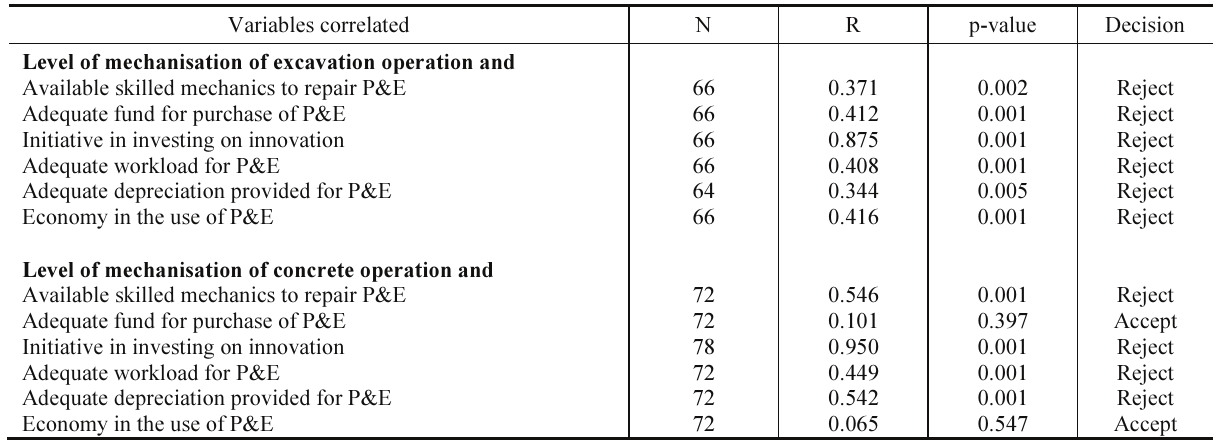
Table 9. Results of Spearman test of correlation between the levels of mechanisation and the levels of sustainability of mechanisation of excavation and concrete operations Variables correlated